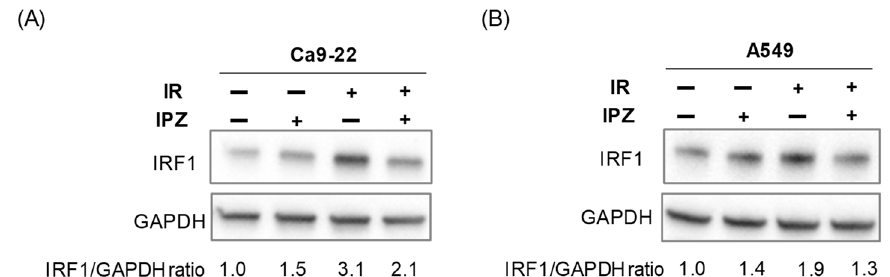
Figure 4. Effects of IPZ on IRF1 expression in irradiated Ca9-22 and A549 cells. ( A , B ) IPZ (10 μ M) was added to the culture medium 1 h before irradiation at 6 Gy. The Ca9-22 ( A ) and A549 cells ( B ) were cultured for 24 and 48 h, respectively, and then harvested for western blot analysis. An image of a representative immunoblot is shown. GAPDH was used as a loading control.